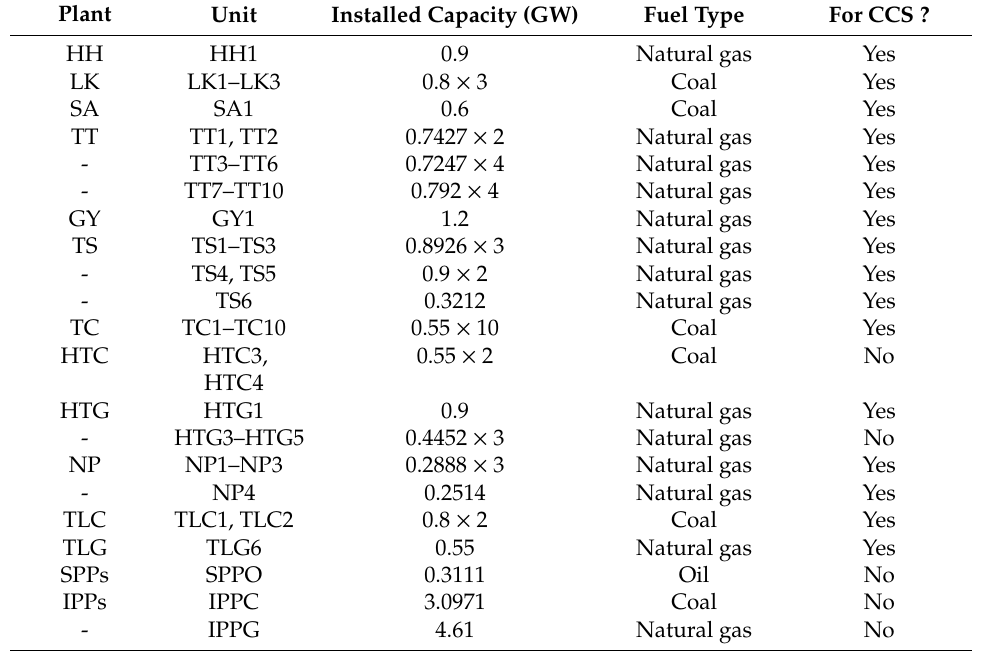
Table 3. Thermal power plants and generation units in the 2025 energy mix.